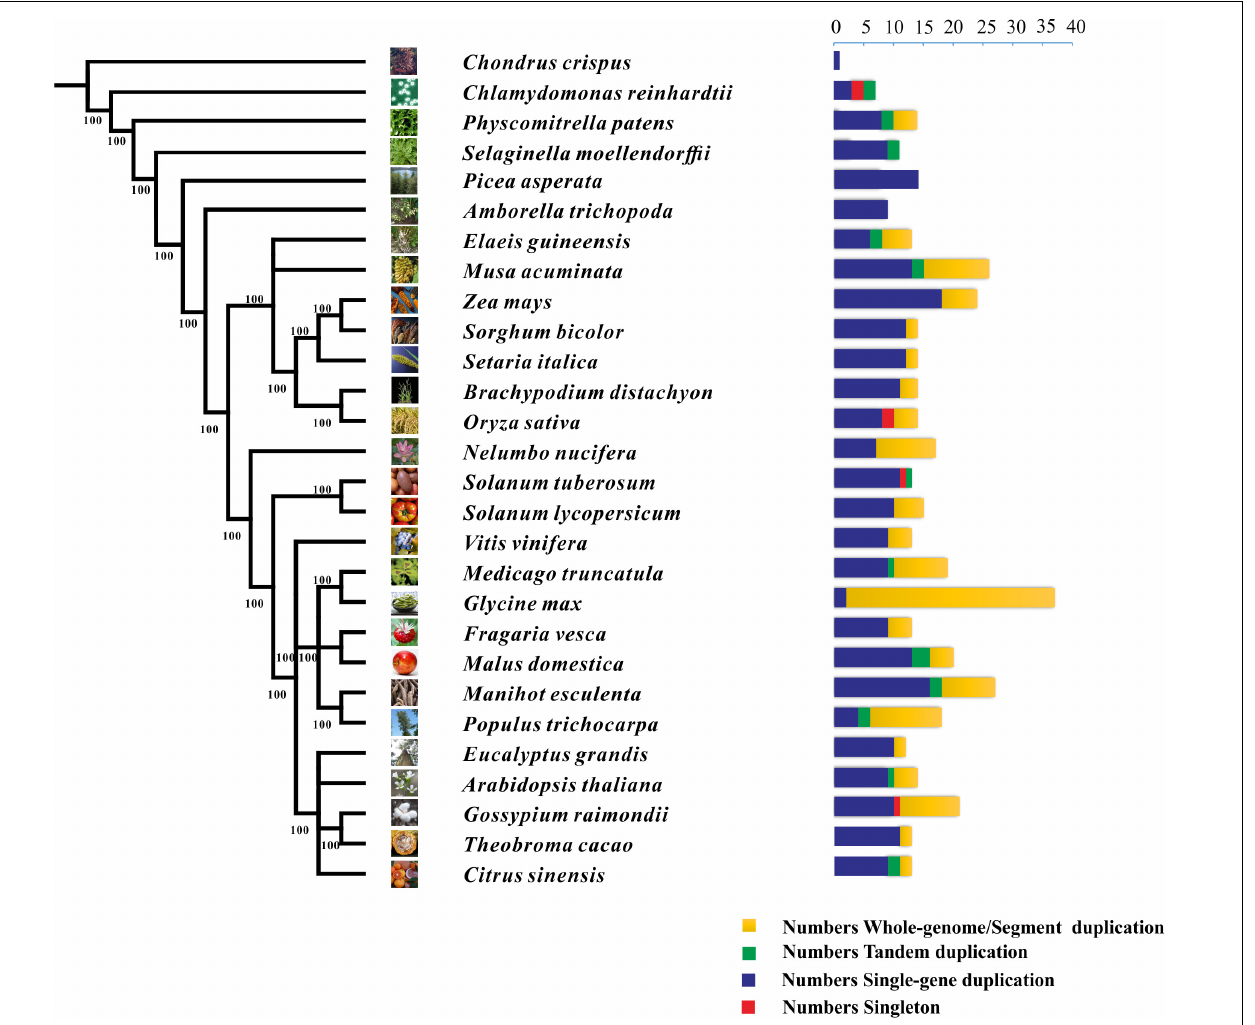
FIGURE 1 | Phylogenetic relationships among 26 species and the duplication modes of the NCS2 gene family. Green, red, yellow, and blue represent tandem, singleton, whole-genome/segmental, and single-gene duplication modes, respectively.